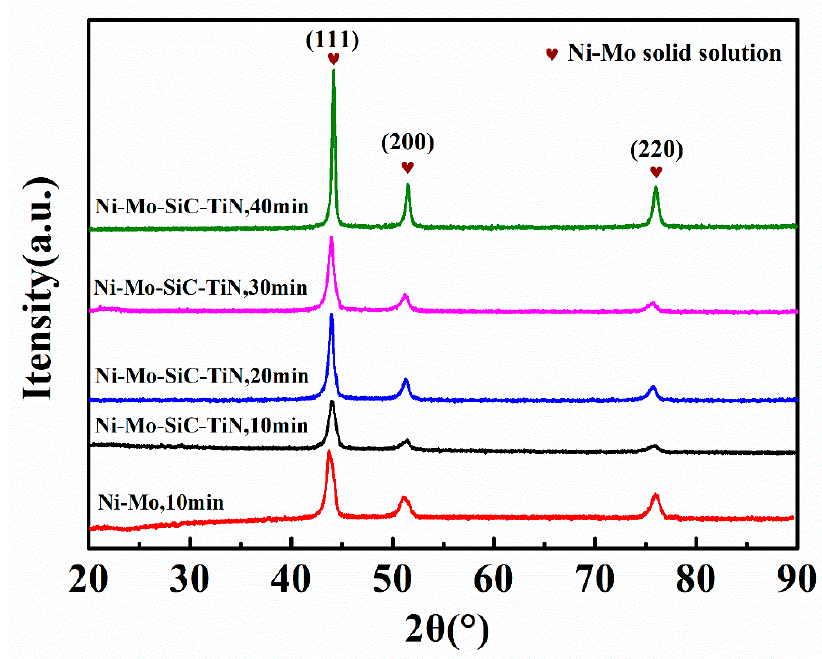
Figure 3. XRD (x-ray diffraction) patterns of coatings electrodeposited by different times.